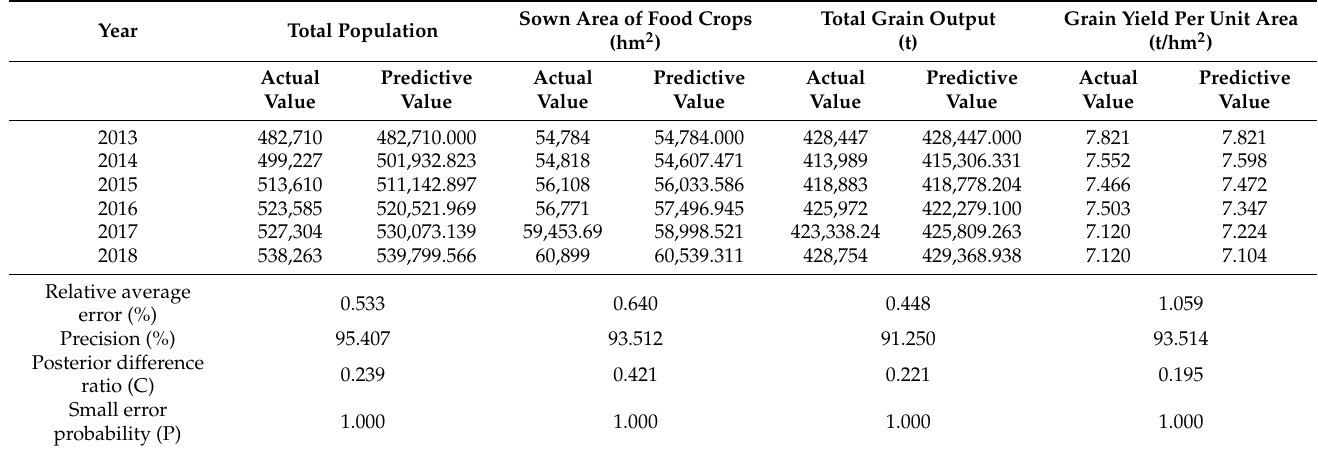
Table 3. Results of model calibration.